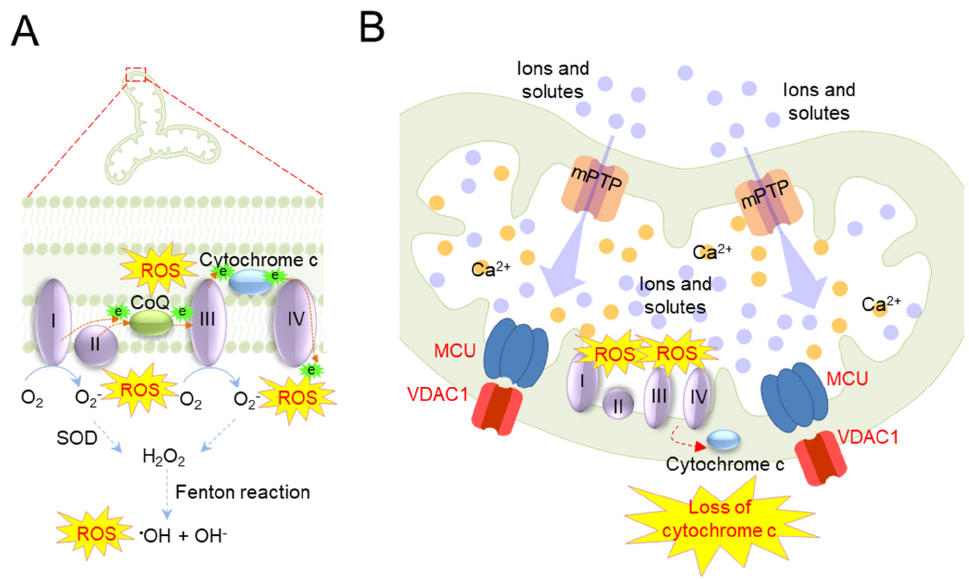
Figure 3. Defective mitochondria are a major cause of mitochondrial ROS generation: ( A ) Complex I damaged by oxidative stress inefficiently transports electrons and subsequently increases electron leakage to oxygen, generating superoxide anions (O 2 − ). Superoxide dismutase (SOD) converts superoxide anions (O 2 − ) to hydrogen peroxide (H 2 O 2 ). Then, hydrogen peroxide (H 2 O 2 ) is partially reduced by the Fenton reaction and converted to a more harmful free radical, the hydroxyl